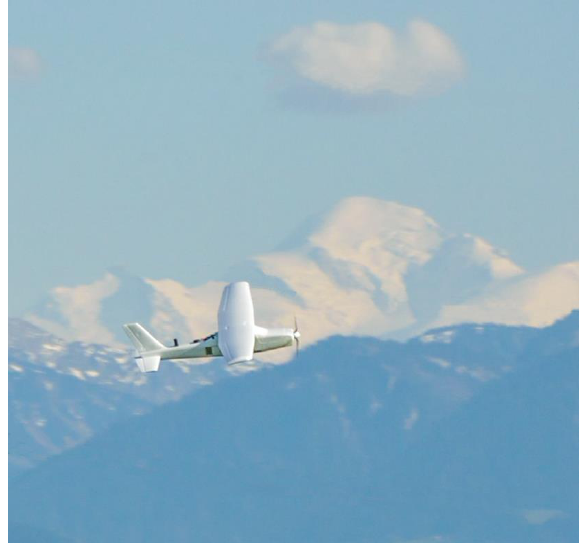
Figure 2. Fixed-wing platform in flight with Mt. Blanc in